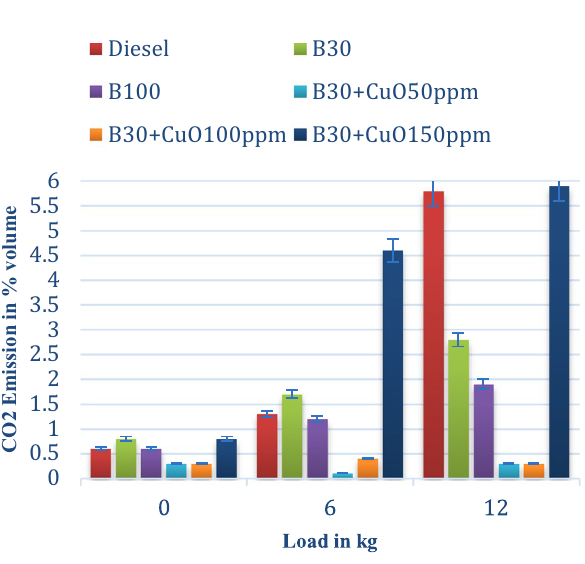
Fig. 2 a FESEM image of CuO nanoparticles. b Image analysis